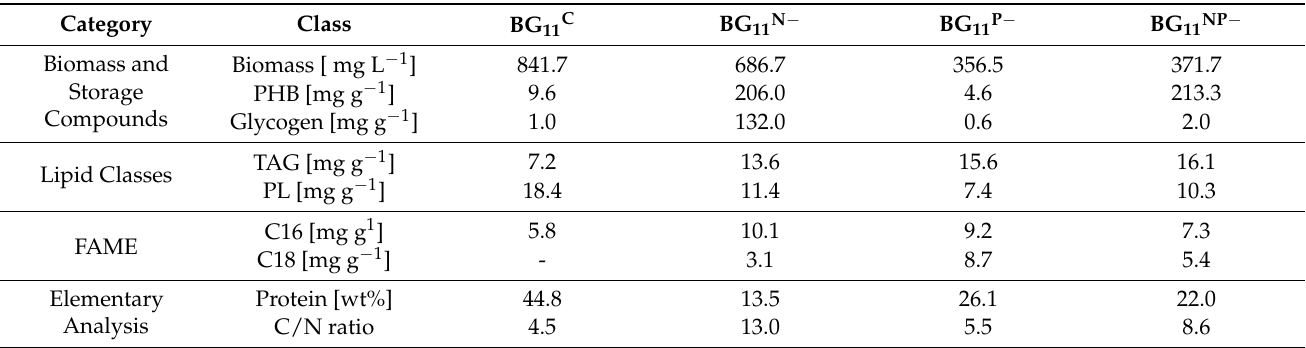
Table 1. Biomass composition of Leptolyngbya sp. NIVA-CYA 255 at the end of the mixotrophic stage. FAME: fatty acid methyl ester, PL: sum of polar lipids, TAG: